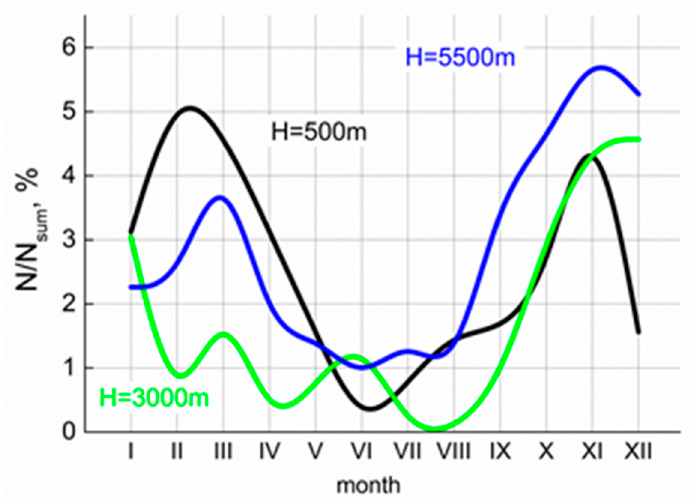
Figure 7. Seasonal behavior of the frequency of occurrence of increased BC eq fraction in aerosol ( P > 0.07) at different altitudes, using aircraft measurements in